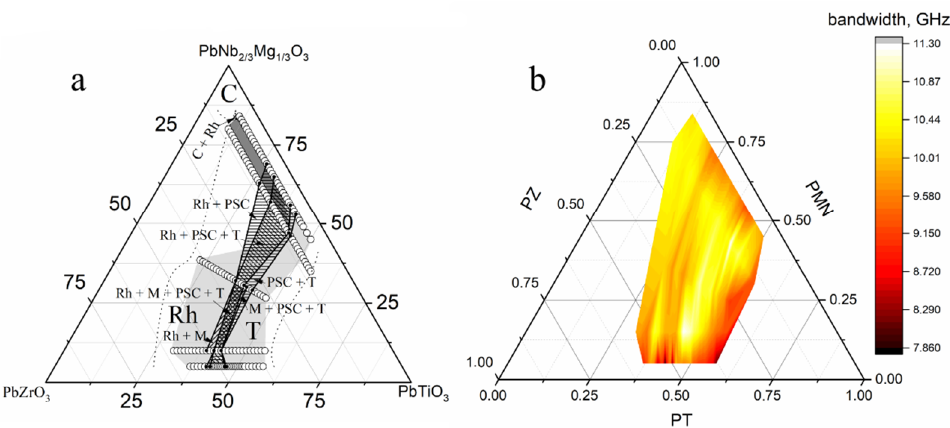
Figure 11. Gibbs triangle of the section for the PMN-PZT-PG system with indication of mor- photropic boundaries: C—cubic phase, Rh—rhombohedral, T—tetragonal, PSC—pseudocubic, M—monoclinic ( a ), and concentration distribution of the effective absorption band ( b ).